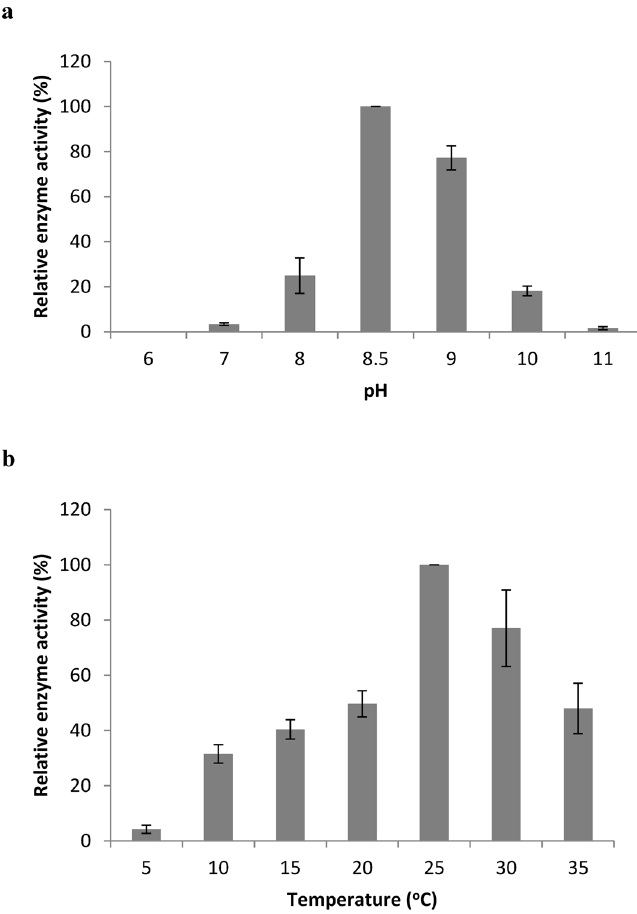
Figure 7. Relative enzyme activity graphs at different pH ( a ) and temperature ( b ) values. The enzyme activity was assayed as described in the materials and methods section. Enzyme activity was zero at 40 °C, thus it was not shown in the graph. Data are expressed as mean ± SD of triplicate